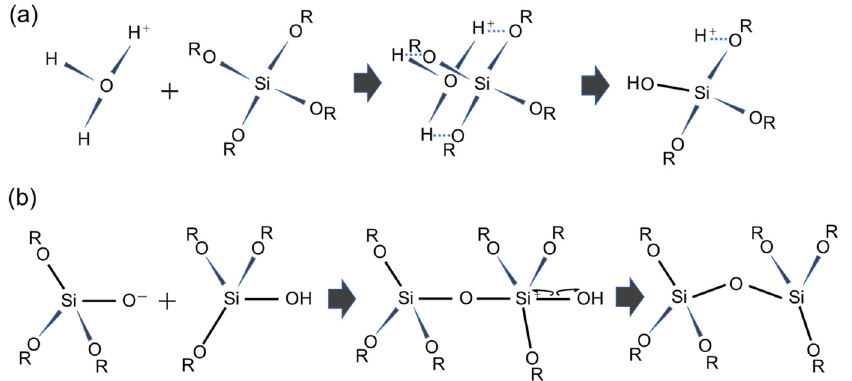
Figure 9. Acid-catalyzed sol–gel process of TEOS. The reaction formula of ( a ) the hydrolysis mechanism and ( b ) the dehydration mechanism.